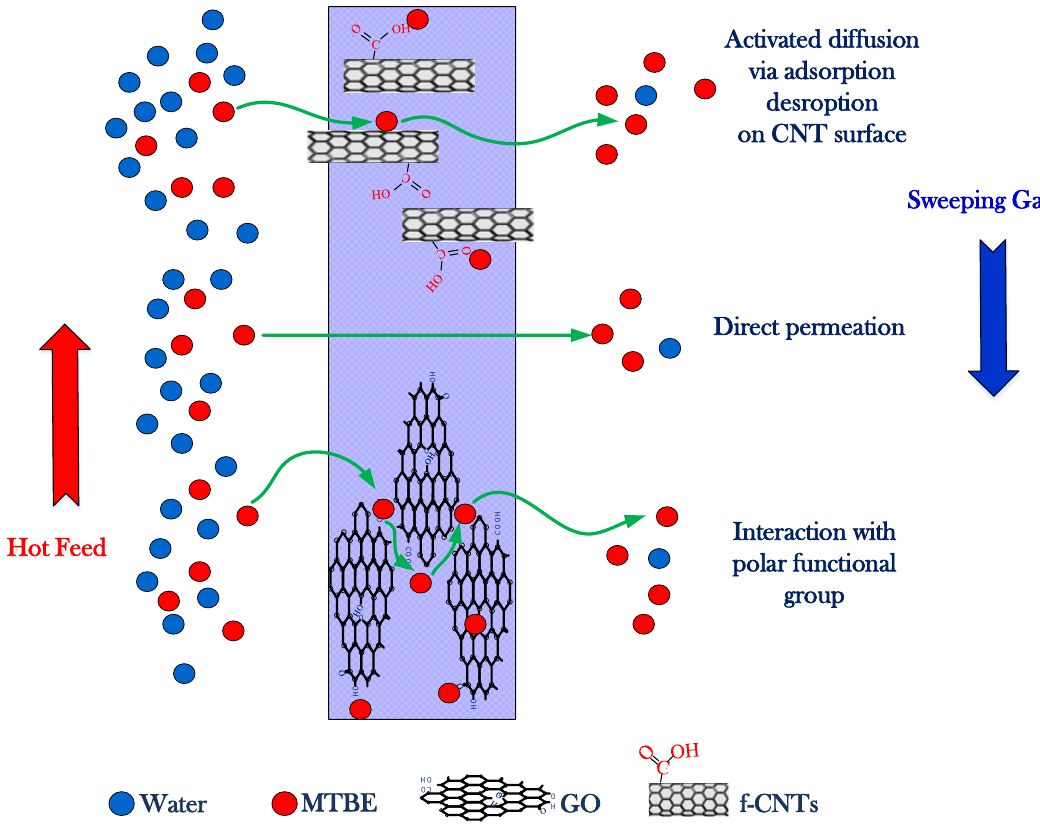
Figure 10. Schematic diagram for mechanism proposed on CNIM-f and GOIM.